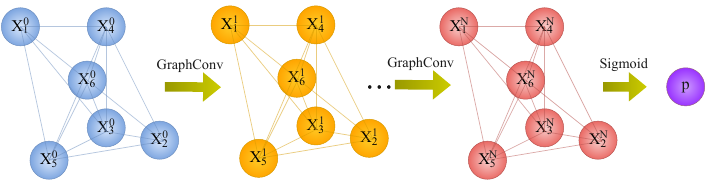
Figure 10 . A schematic architecture of the edge convolutional neural network (EdgeConv) used in this